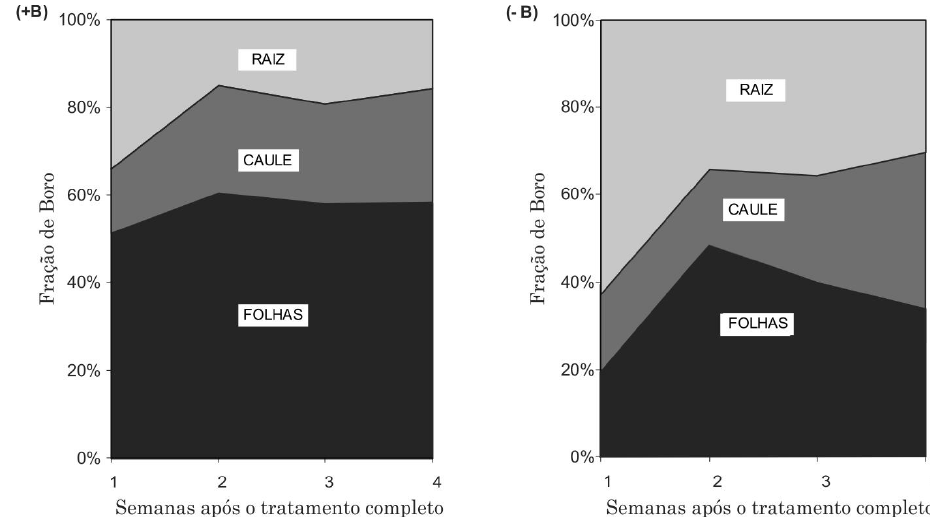
Figura 3. Percentagem de distribuição do B acumulado nos tecidos vegetais (folhas, caule e raiz) de cultivares de algodão com boro (+B) e sem boro (-B), nas quatro semanas de avaliação (média de quatro